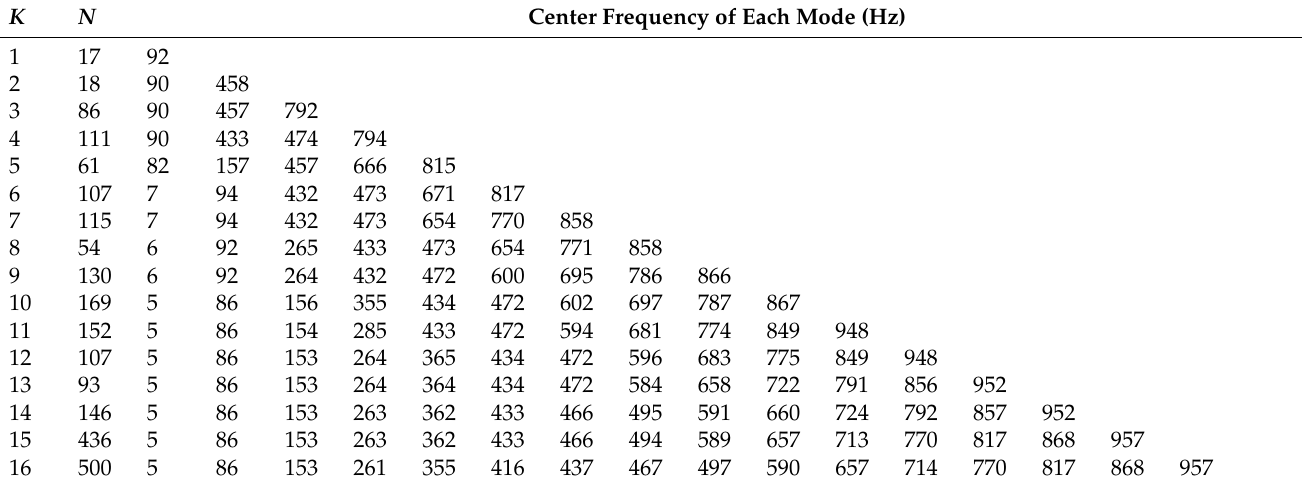
Figure 6. Vibration signal frequency domain double-logarithmic coordinates. Table 3. Center frequency and number of iterations corresponding to different K values.